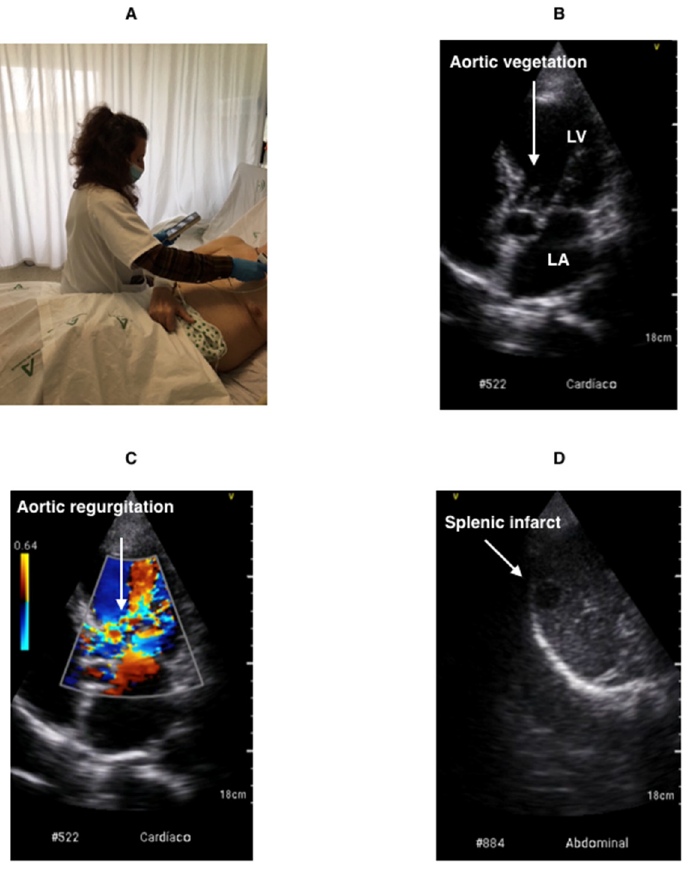
Figure 1. Demonstration of the POCUS technique. ( A ). POCUS at the patient’s hospital bedside. ( B ). Vegetation on aortic valve. ( C ). Severe aortic regurgitation. ( D ). Splenic infarction. LA: left atrium. LV: left ventricle.